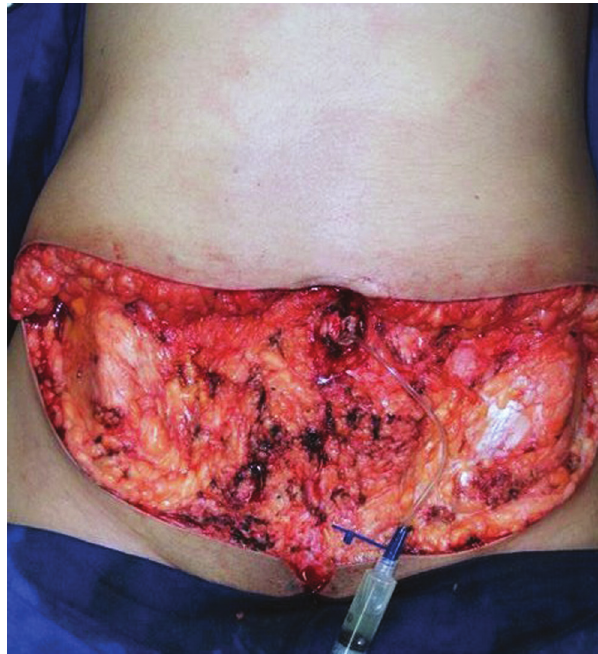
Figure 1 - Catheter located in the vesical conduct, showing the localization of the